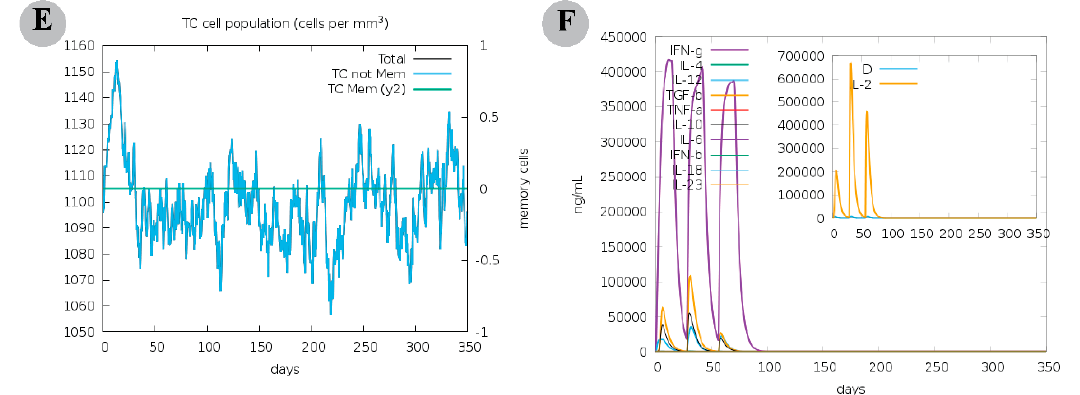
Figure 2. Computation immune simulation of an infection challenge that included Congo virus proteins sequences covered by the designed chimeric vaccine was simulated for 350 days. ( A ) Antibodies response against the antigen (or virus). Following the antigen injection, antibodies and immunocomplexes indicate the induction of humoral immune response with a change toward a variety of antibodies subtypes (with IgG subtype being the predominant one). ( B ) Population of B lymphocytes in a cell per mm 3 in terms of the total count, generation of memory cells, and induction of several isotypes, including IgM, IgG1, and IgG2. ( C ) Concentration of total and memory CD4+ T-helper (TH) lymphocytes. ( D ) Concentration of CD8+ T-cytotoxic (TC) lymphocytes in several forms, i.e., active, duplicating (in the mitotic cycle), resting (not active), and anergic. ( E ) The cell count of total and memory CD8+ T-cytotoxic (TC) lymphocytes. ( F ) Levels of cytokines and interleukins. D in the inset plot is a danger signal and leukocyte growth factor IL-2.